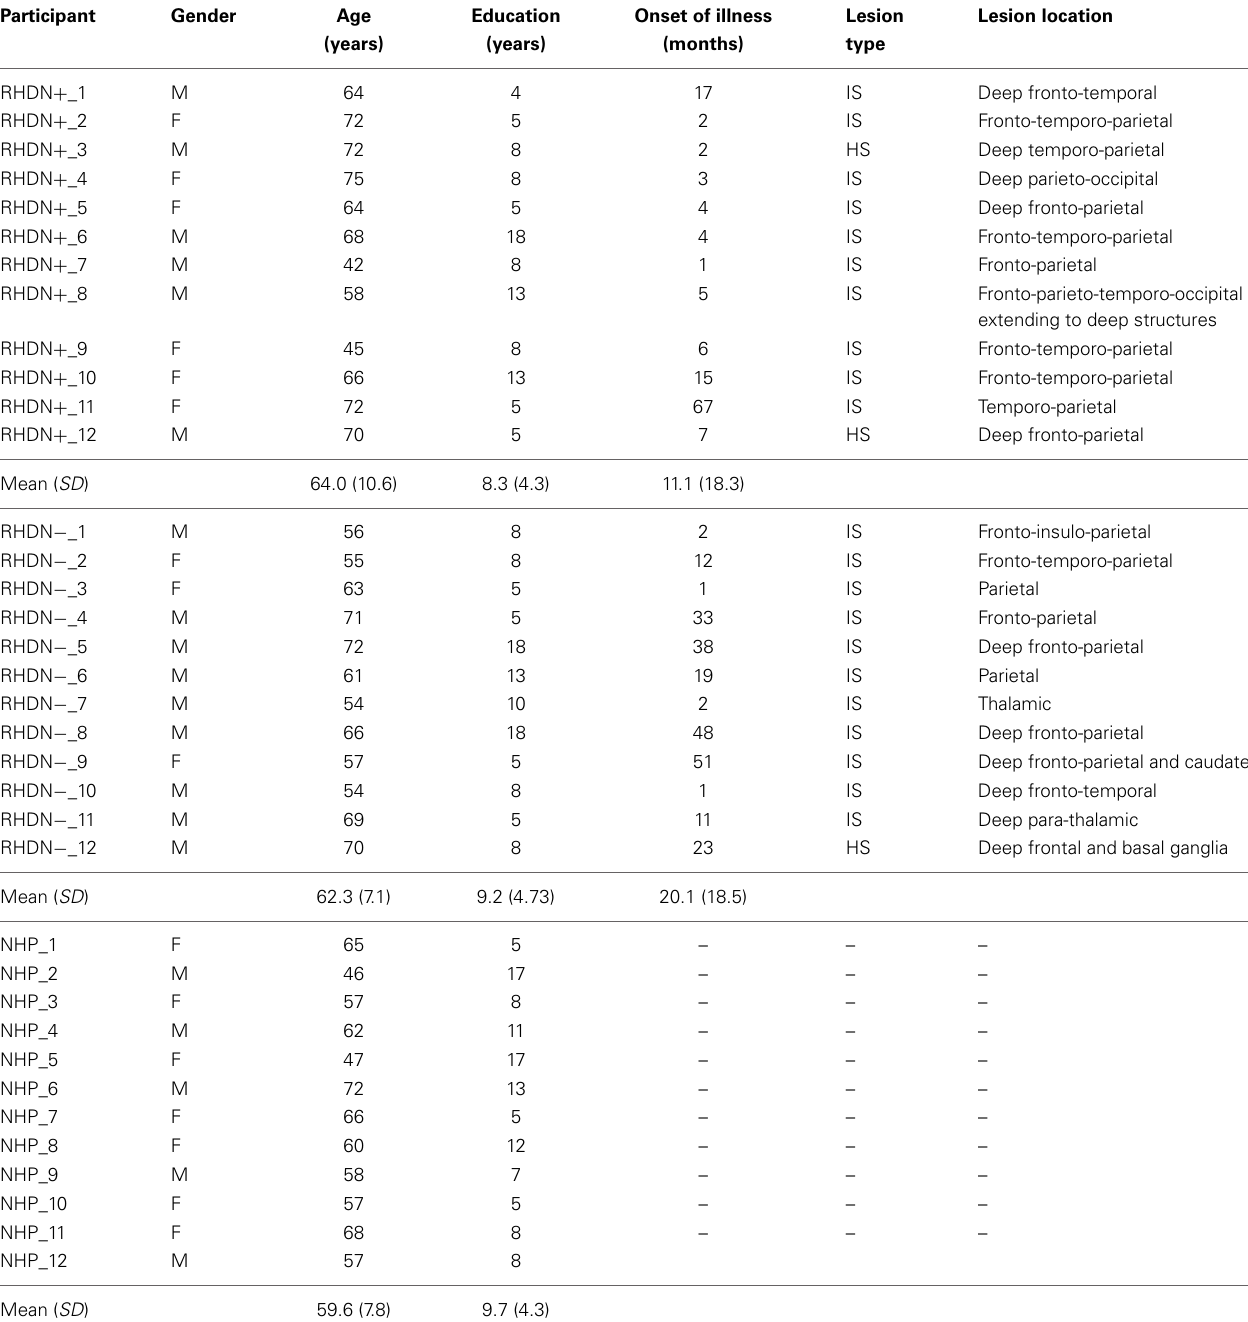
Table 1 | Demographic and clinical data of all the